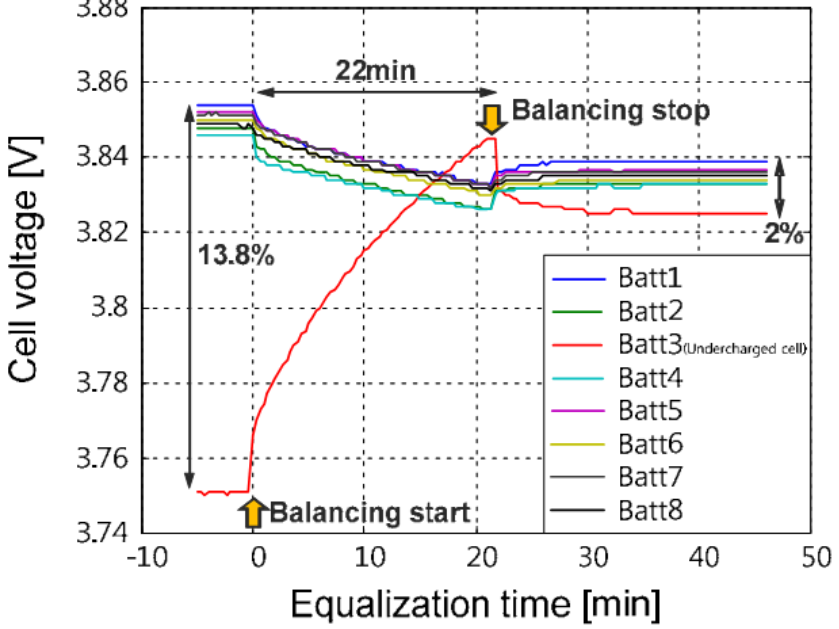
Figure 16. Experimental wave forms about multi-output